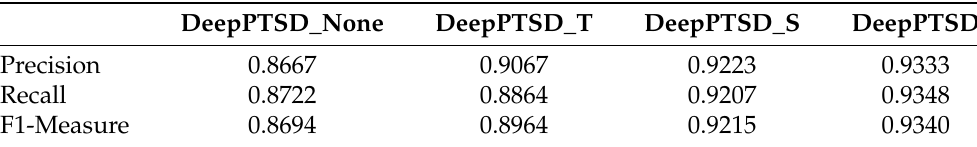
Table 4. The evaluation of the payload data augmentation